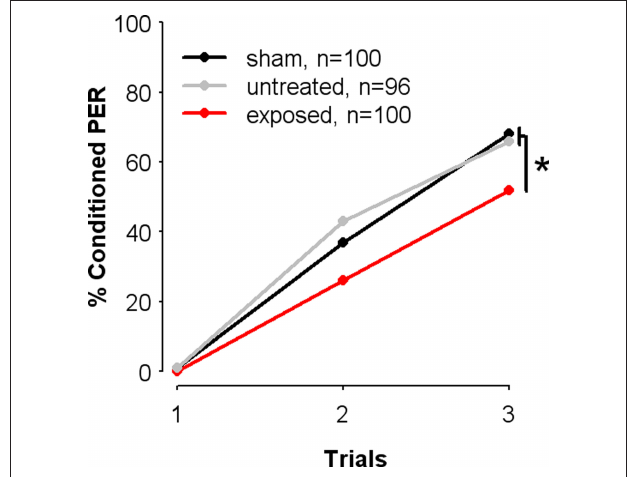
Figure 2 | exposure to the natural blend of the sting alarm pheromone impairs olfactory learning. Learning performances measured as the percentages of conditioned proboscis extension responses (percentage conditioned PER) elicited by the CS, 1-nonanol (conditioned PER) during three conditioning trials. Learning was impaired in bees previously exposed to the SAP ( exposed ), as compared with control groups ( sham and untreated ). * p <